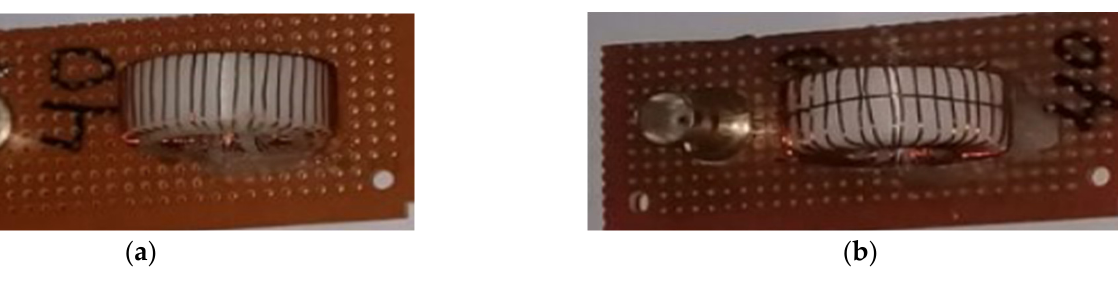
Figure 7. RC sensors with 40 turns tested in [85]: ( a ) without back wire, and ( b ) with back